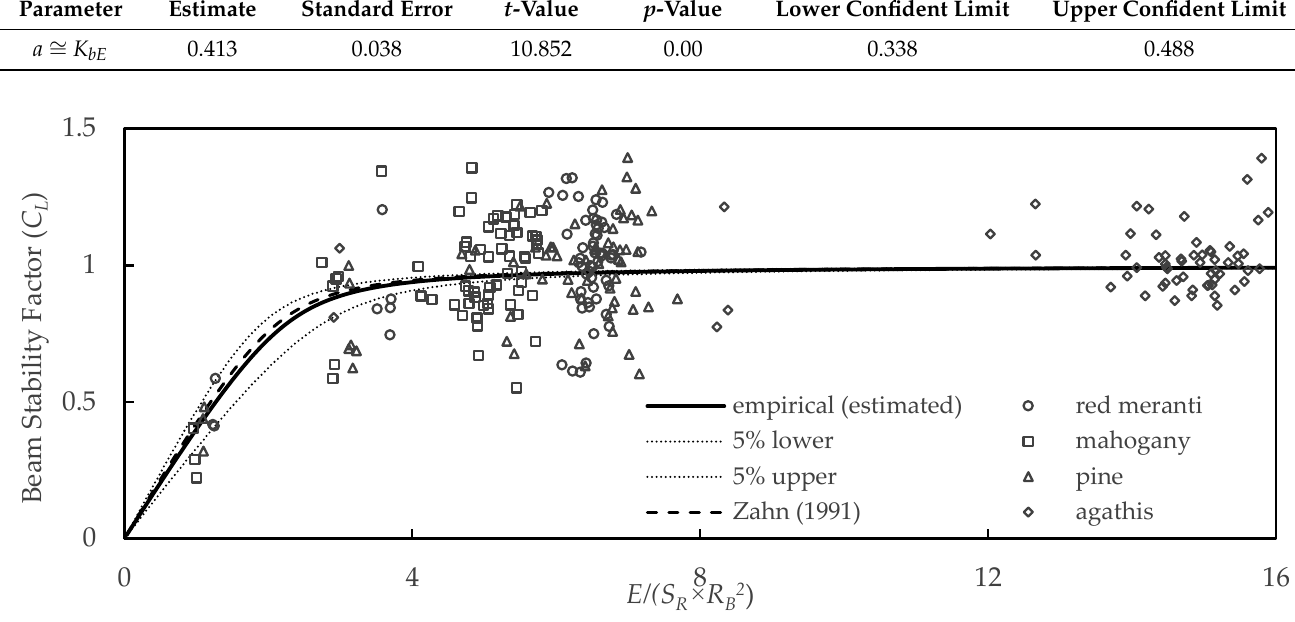
Figure 7. Nonlinear estimation of the empirical beam stability factor ( C L , e ) curve compared to Zahn’s C L curve [41] (Note: Modulus of elasticity ( E ) and modulus of rupture ( S R ) on abscissa were obtained from the average value of the small specimen bending tests).